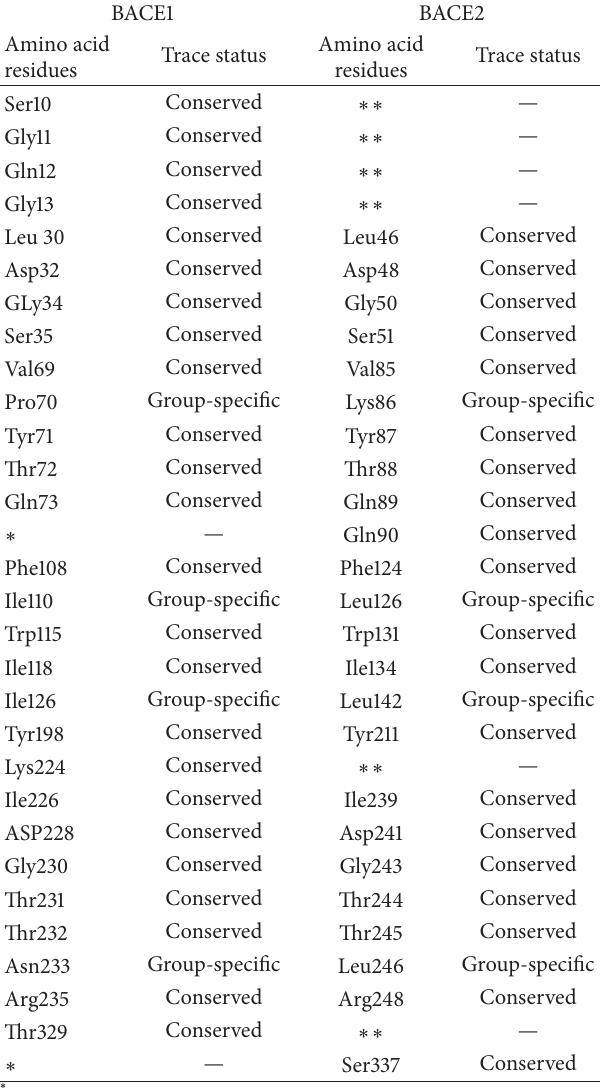
Table 1: Amino acid residues at the ligand binding sites of BACE1 and BACE2. The amino acid residue numbering is according to their respective 3D structure (1FNK and 2EWY).